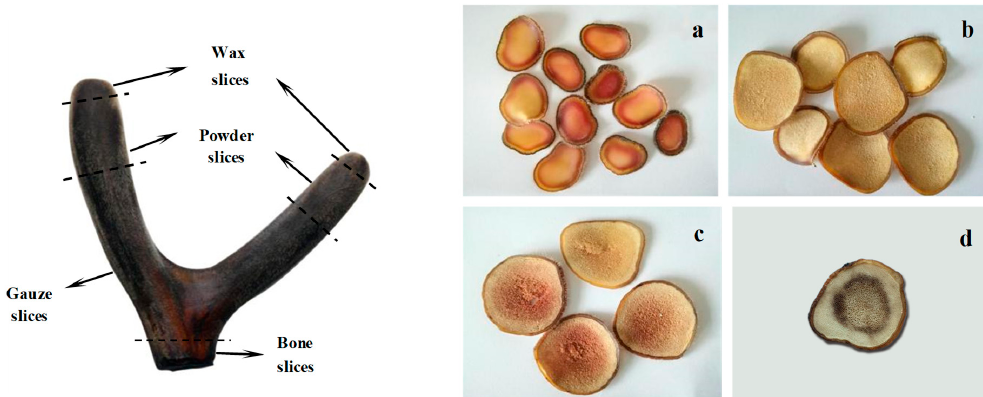
Figure 4. Schematic diagram of different parts of processed velvet antler. The processed velvet antler was divided into wax slices ( a ), powder slices ( b ), gauze slices ( c ), and bone slices ( d ) on the basis of morphological and microscopic characteristics.